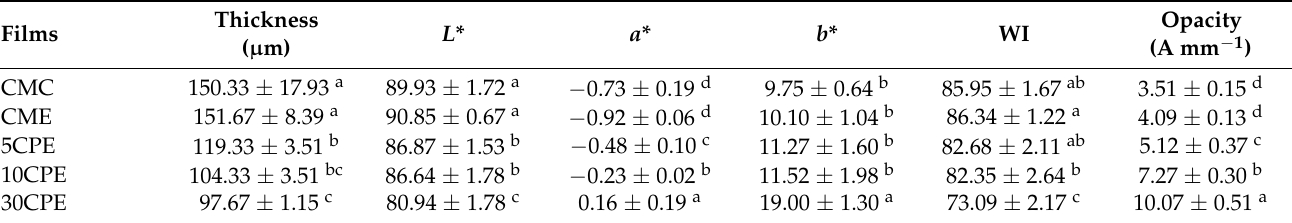
Table 3. Thickness and color properties of